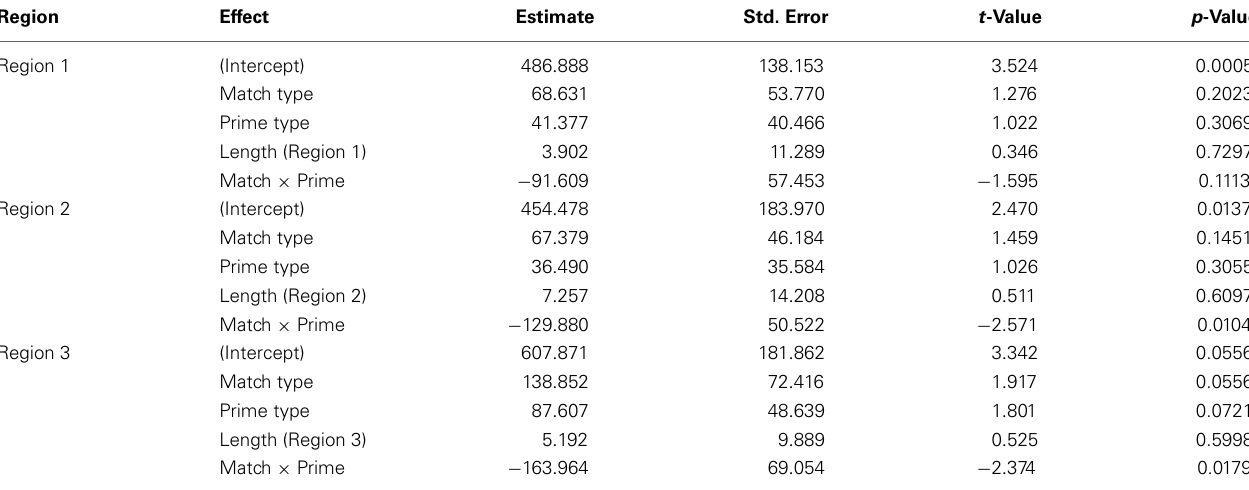
Table 3 | Model estimates and statistics for the Literal sentences. Region